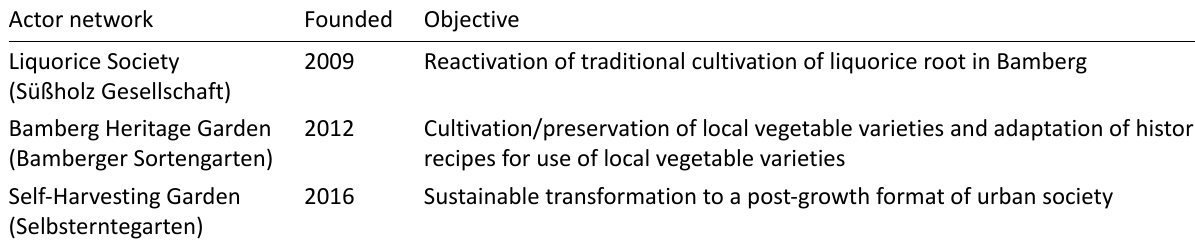
Table 2. Actor networks introducing evolutionary processes within Bamberg’s